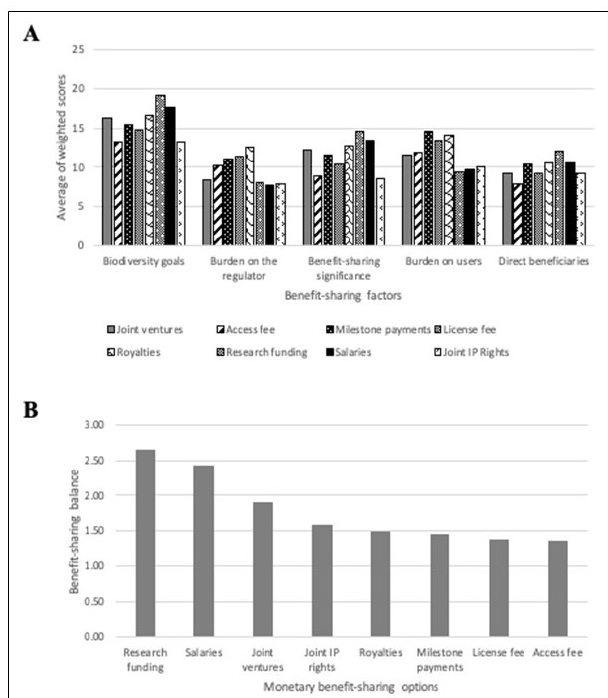
Figure 4. A) Average weighted scores for the eight monetary benefit-sharing options according to the five benefit-sharing factors, and B) scores according to the benefit-sharing balance equation for the eight monetary benefit-sharing